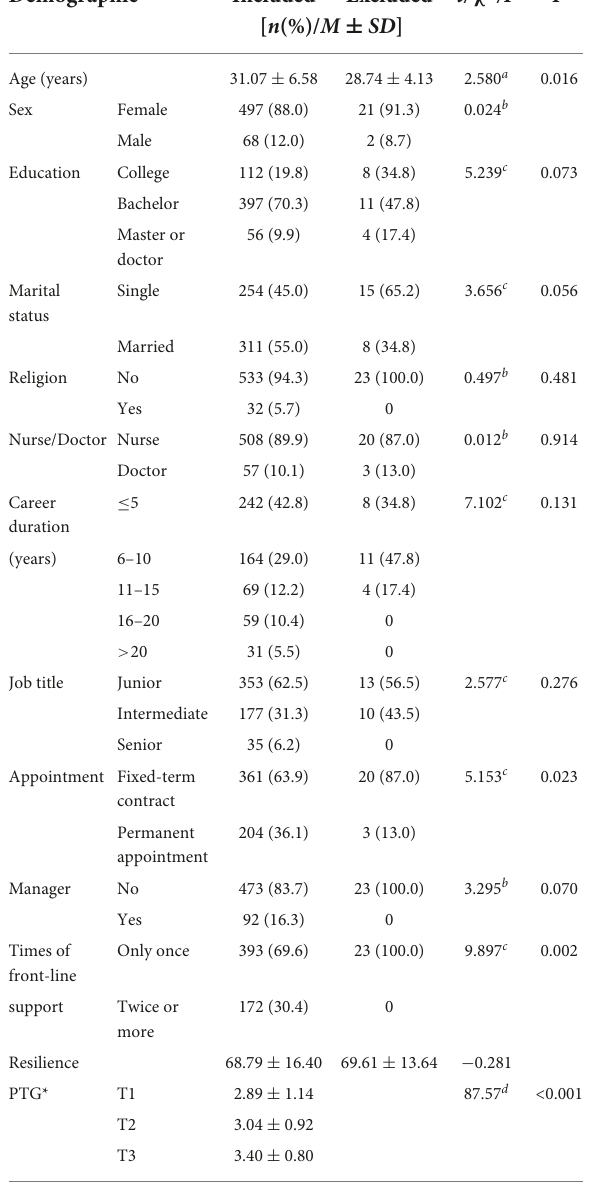
TABLE 1 Demographics, resilience, and PTG of participating healthcare workers ( N =